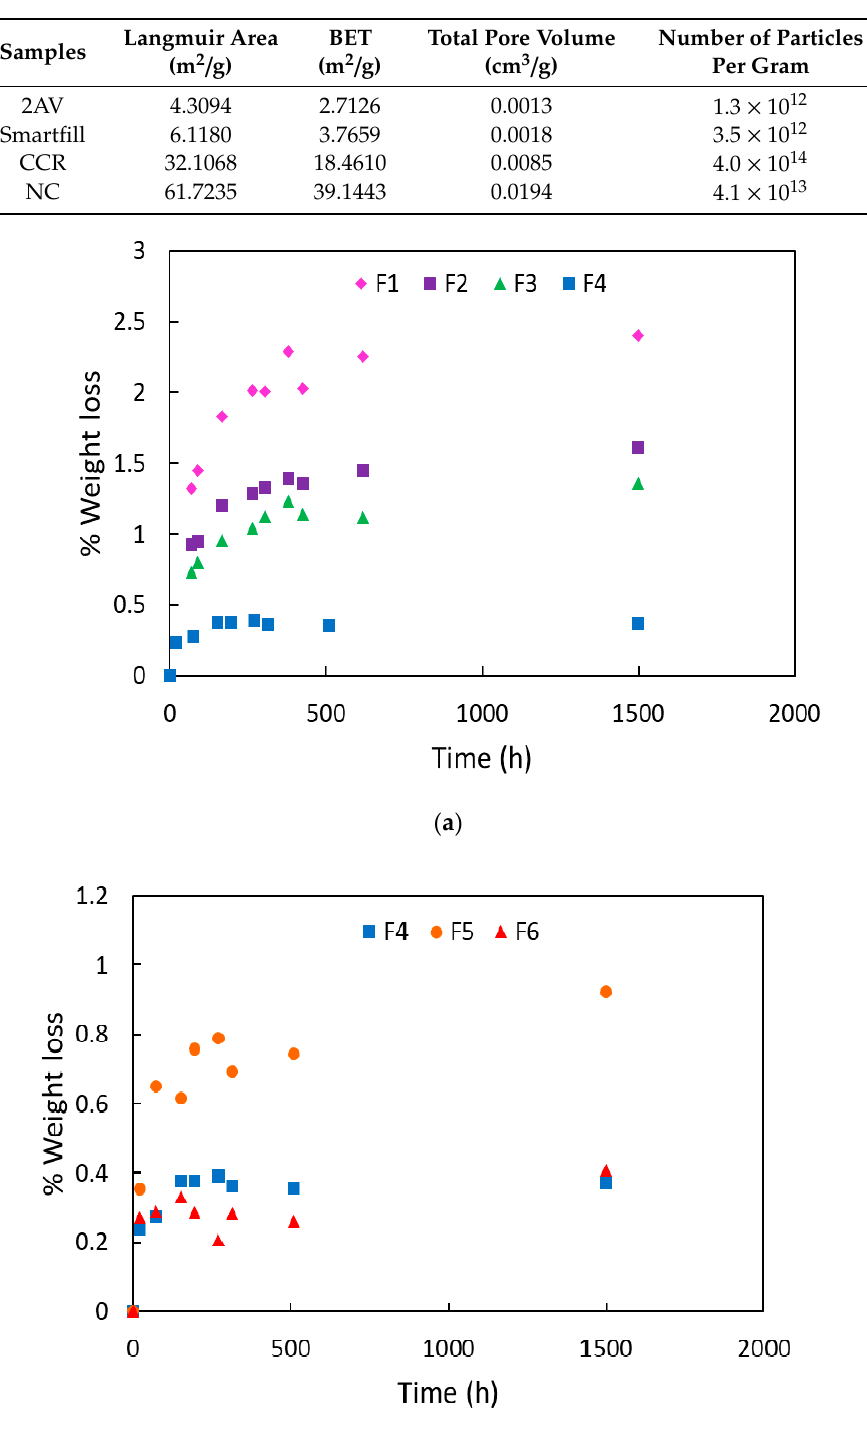
Table 3. Surficial areas, porosity, and number of particles per gram of the four fillers used in this paper.